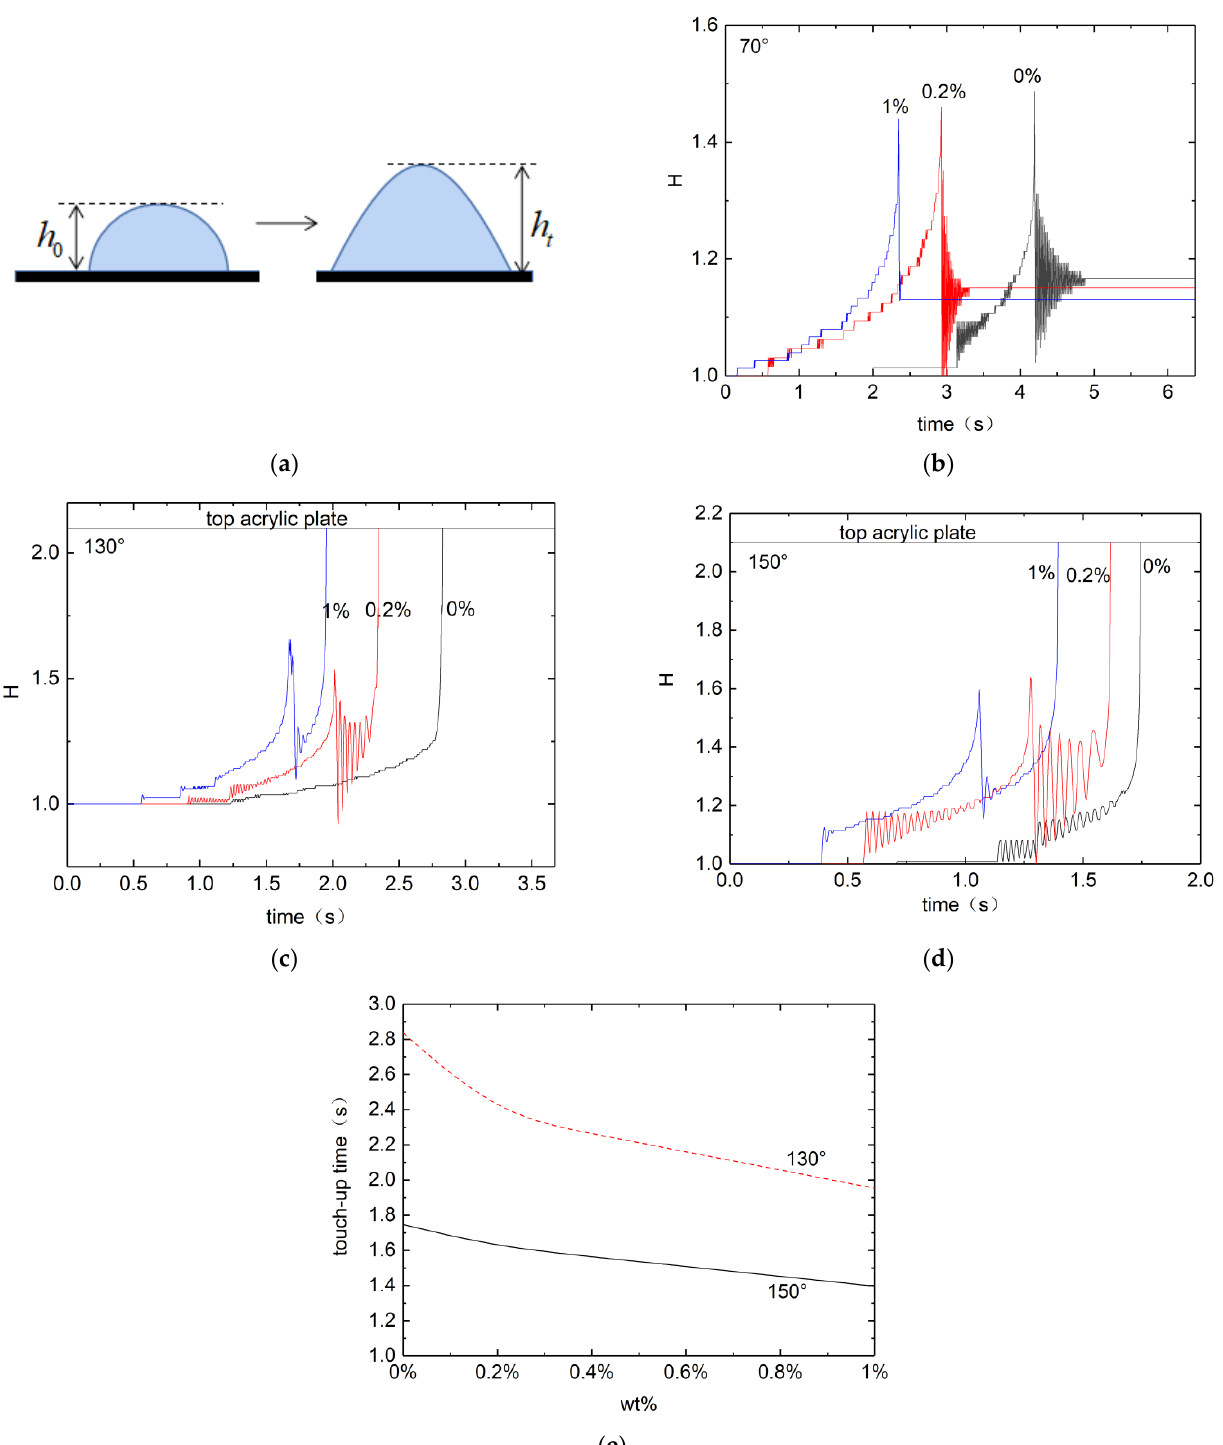
Figure 2. Deformation process of water, low-concentration PEO aqueous solution, and high-concentration PEO aqueous solution at different contact angles. ( a ) Initial and deformed droplet configuration. ( b – d ) Dimensionless droplet height evolution for contact angle of 70° , 130° and 150° . ( e ) Dimensionless time required for droplet tip to reach the top acrylic plate against PEO concentration. Voltage applied through the pin-plate electrode system is 11 kV. It is observed that on a hydrophilic substrate droplets tend to equilibrate to a final stationary state. For low voltage applied the equilibration is monotonic, whereas for high